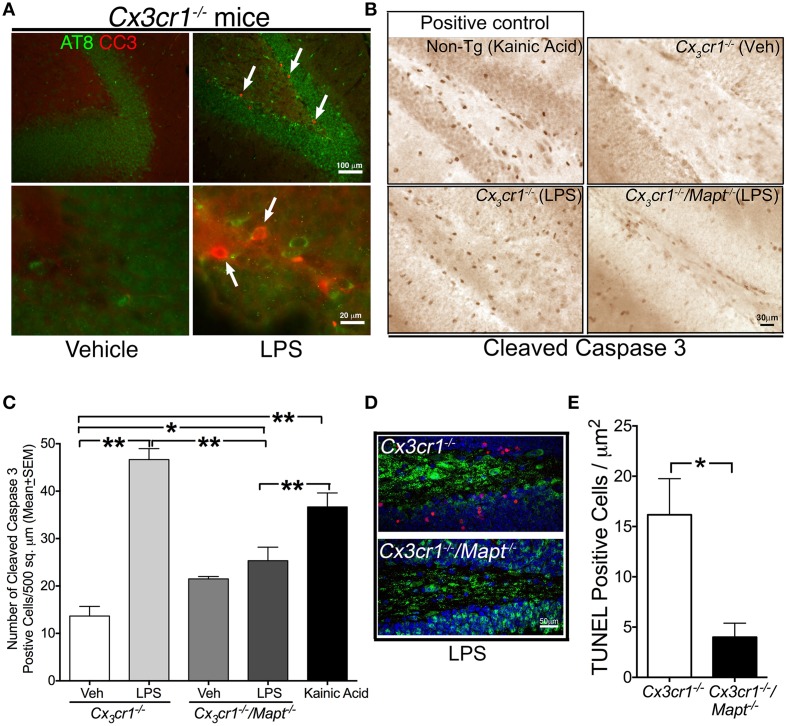
Tau deficiency reduces LPS-induced neurotoxicity in
Cx3cr1−/− mice. (A) Two-month old Cx3cr1−/− mice were injected with single dose of vehicle (left panel) or LPS (right panel) (1 mg/kg b.w, daily for 3 days; i.p). Brain sections were double immune-labeled with AT8 (phospho-tau at Ser199) and CC3 antibodies. Presence of AT8 (green) and CC3 (red, arrows) positive cells were detected only in LPS treated samples, primarily in the same sub-population of dentate gyrus. Top panel-low magnification; bottom panel-high magnification. Scale bar 100 μm in top panels and 20 μm in bottom panels. (B) The number of cells immunoreactive for CC3 is relatively higher in the DG of 2-month-old Cx3cr1−/− mice administered with LPS compared to 2-month-old Cx3cr1−/− mice injected with vehicle (Veh). Deficiency of tau in Cx3cr1−/−/Mapt−/− mice shows markedly reduced numbers of CC3+ cells following administration of a similar concentration of LPS. As a positive control, 2-month-old non-transgenic mice treated with kainic acid (20 mg/kg b.w, single dose; i.p.) showed a substantial number of CC3+ cells in the DG. Scale 30 μm. (C) Quantification of CC3+ cells reveals a statistically significant (**p < 0.01; One-Way ANOVA with Tukey multiple comparison test; n = 4 mice per group) increase in CC3+ cells in the LPS treated Cx3cr1−/− mice compared to the Veh treated mice. Note LPS-treated Cx3cr1−/−/Mapt−/− mice showed significantly less CC3+ cells (**p < 0.01; One-Way ANOVA with Tukey multiple comparison test; n = 4; mean ± SEM) compared to LPS-treated Cx3cr1−/− mice or KA-treated mice. Other comparisons are also shown (*p < 0.05 or **p < 0.01). (D,E) The number of NeuN+ neurons (green), which are immunoreactive for TUNEL (red) in the granule cell layer of DG is significantly (*p < 0.05; unpaired t-test; n = 4 mice per genotype; mean ± SEM) higher in the LPS-treated Cx3cr1−/− mice compared to the LPS treated Cx3cr1−/−/Mapt−/− mice. Scale bar is 50 μm.